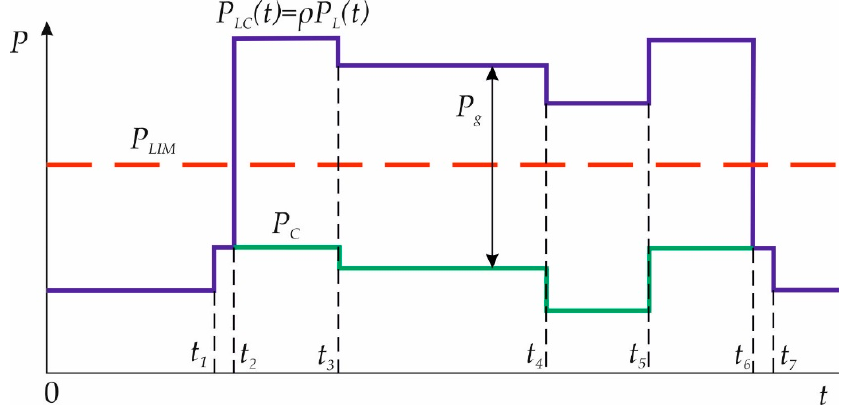
Figure 1. The structure of the system (VSI—a grid multifunctional inverter, DC/DC2—voltage converter of PV, DC/DC1—voltage converter of WG, DC/DC3—voltage converter of SB, WFM— Wi-Fi module, CS—control system unit, DG—distribution grid).